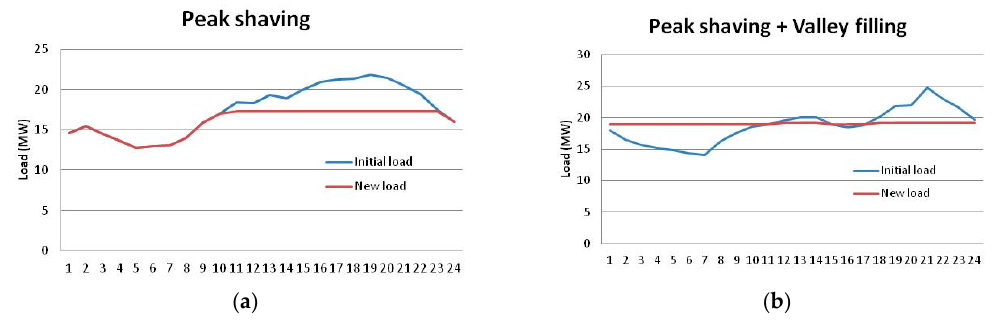
Figure 14. Variation of daily load curve considering P pump = 15 MW and P hydro = 10.5 MW: ( a ) Peak shaving operation of hybrid power station (day 4 of the year); ( b ) peak shaving and valley filling operation of hybrid power station (day 206 of the year).